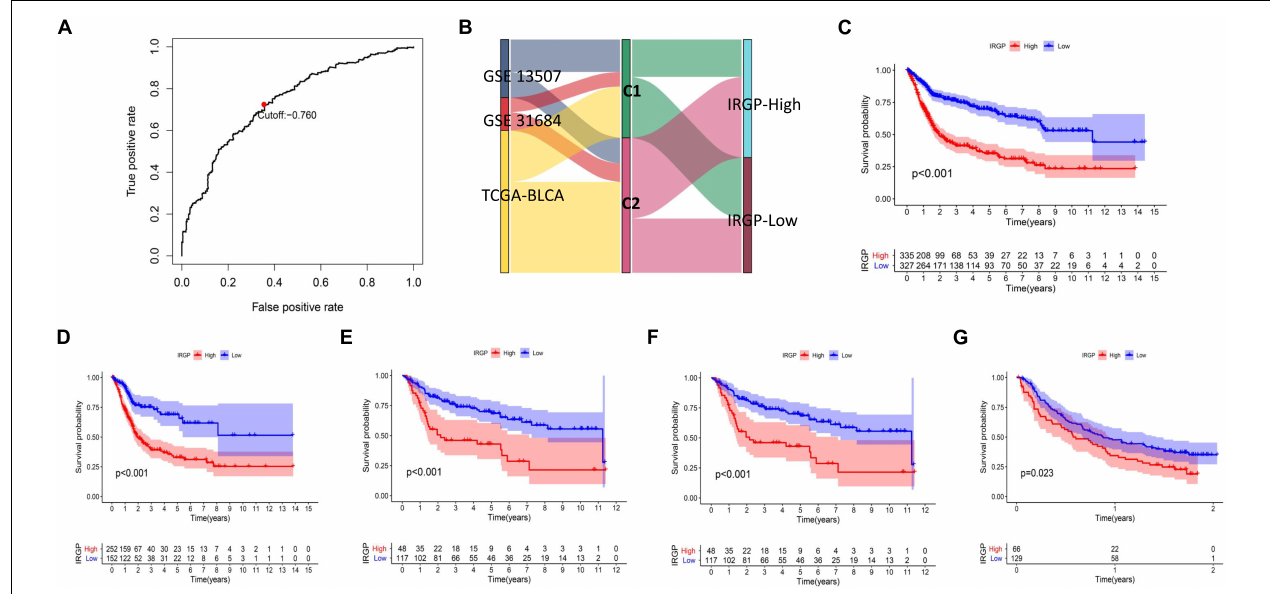
FIGURE 2 | Construction and validation of prognostic IRGP-signature. (A) Sankey chart displays the distribution of the consensus clustering in C1, C2, IRGP high-, and low-risk groups. (B) Time-dependent ROC curve for IRGP-signature in the training cohort. KM curves of overall survival among different IRGP risk groups in the